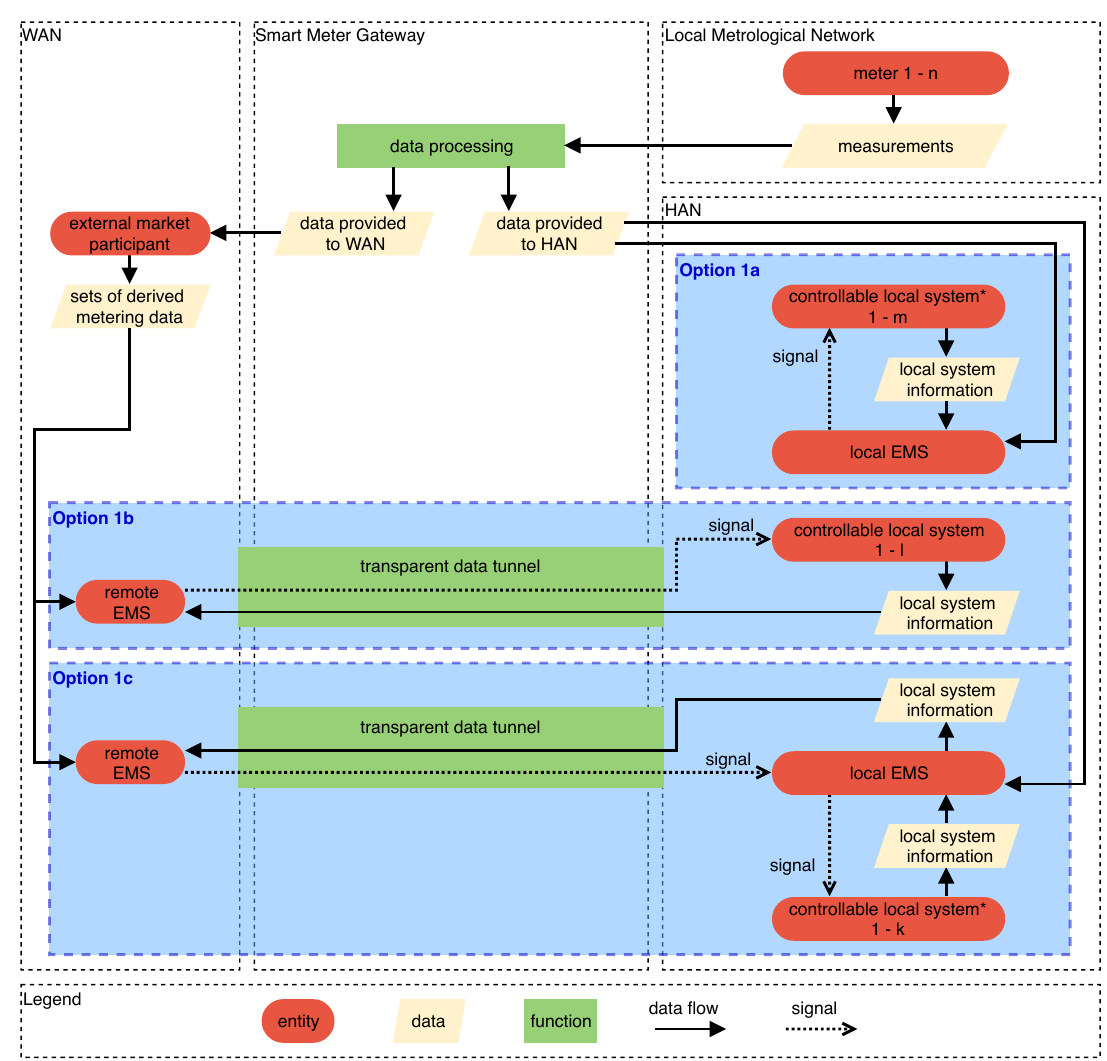
Figure 2. Integration options for Energy Management Systems (EMSs) using the interfaces provided by the Smart Meter Gateway . Controllable Local Systems that are only monitored and controlled from inside the Home Area Network (HAN) are marked with an